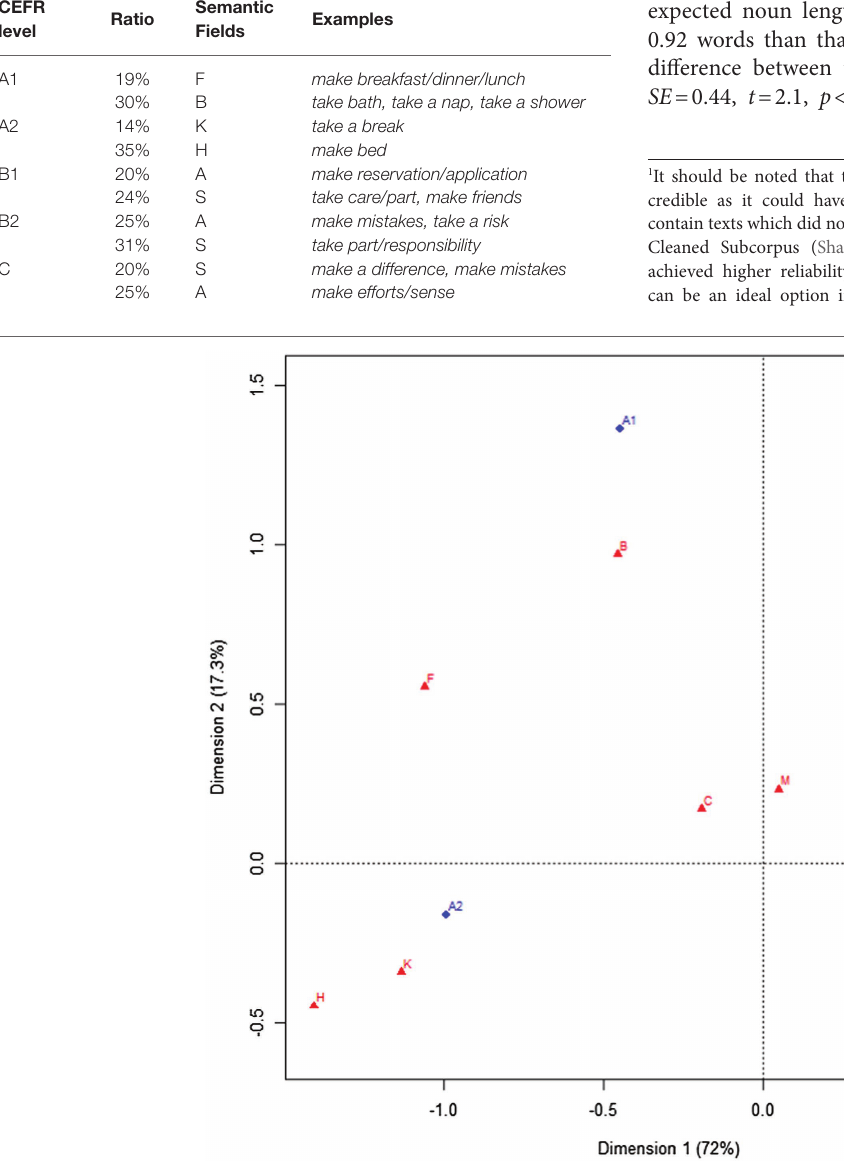
TABLE 4 | Top two semantic fields at each